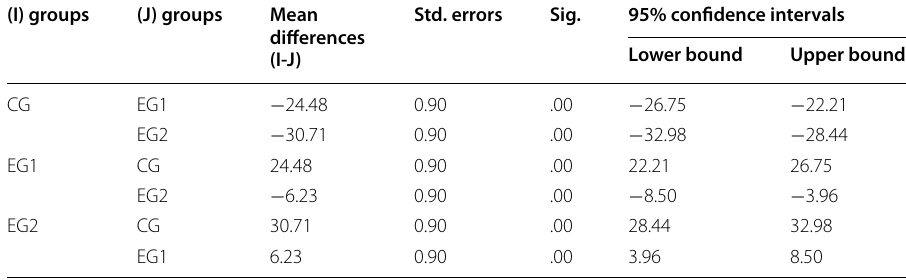
Table 8 Outcomes of the Scheffe post-hoc test: the participants’ post-test of speaking accuracy